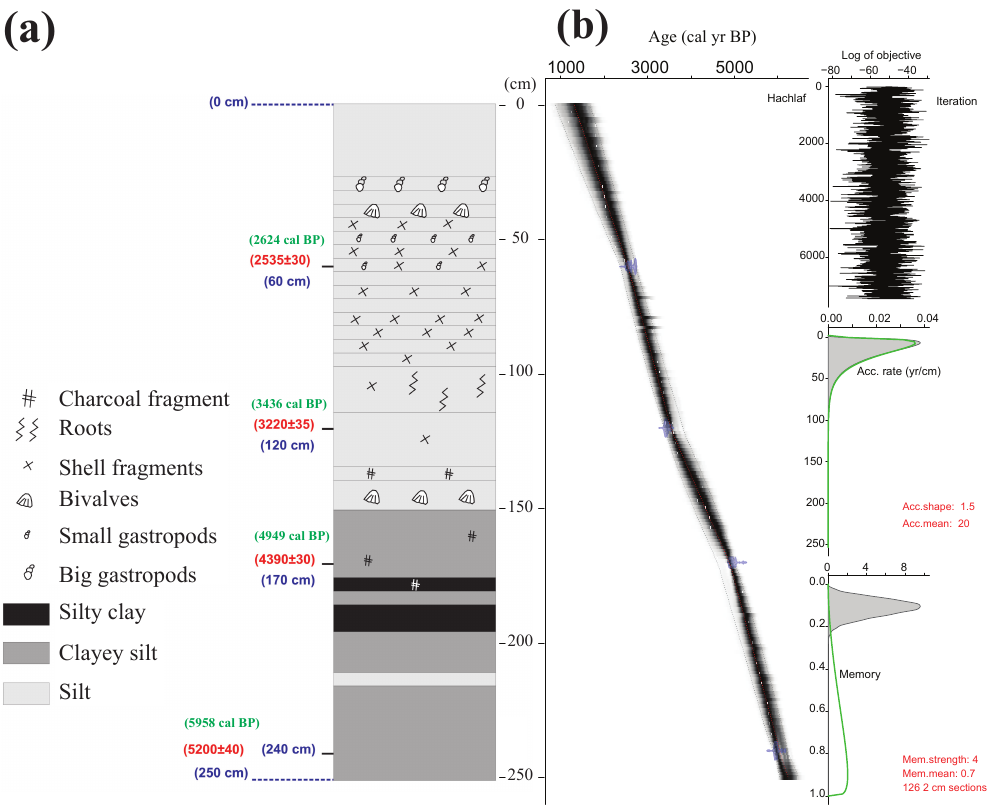
Figure 2. (a) Lithology of the core Hach-I and radiocarbon 14 C dates; (b) age–depth model from BACON software (Blaauw and Christen,